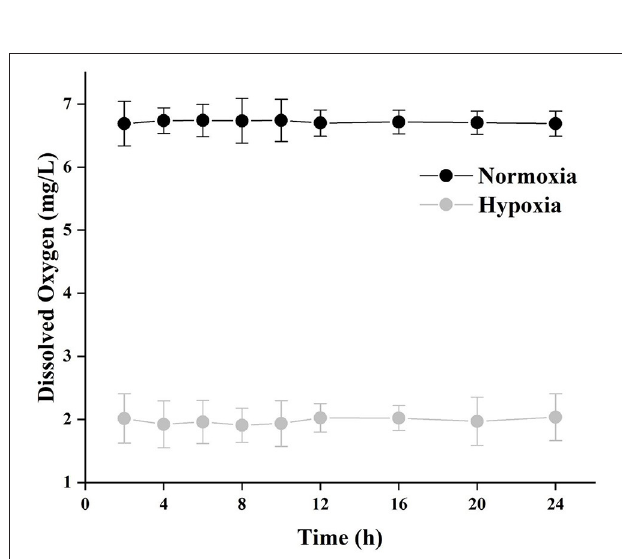
FIGURE 2 | The data of dissolved oxygen (DO) under normoxia and hypoxia after renewing the water every day ( N = 15). The X -axis is the time after renewing the water, and the Y -axis is the DO at the corresponding